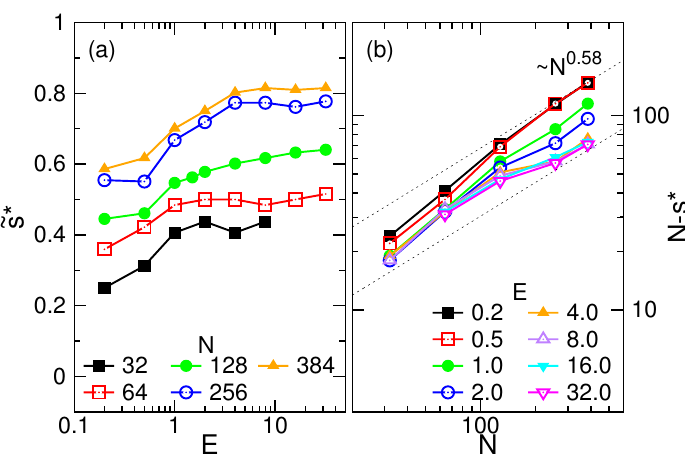
Figure 8. ( a ) Hump position ˜ s ∗ of the normalized waiting time function ˜ w ( ˜ s ) , as a function of E . The number of monomers N is indicated in the figure. ( b ) ( N − s ∗ ) vs. N at different field strengths E .